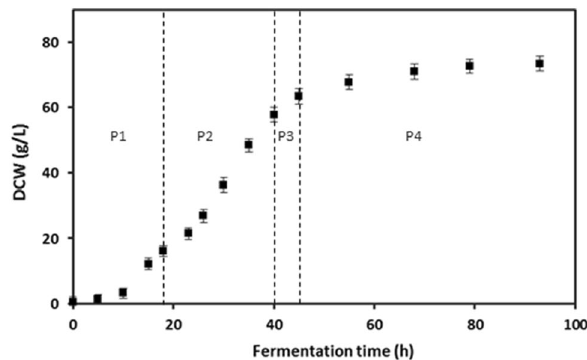
Figure 10. P. pastoris biomass concentration (g DCW/L) evolution during bioreactor fermentation. P1: batch phase in LSBM glycerol 40 g/L, P2: Fed-batch phase with 600 g/L glycerol solution, P3: Adaptation phase with glycerol (600 g/L):methanol (3:1) mixture, P4: Induction phase with methanol as the sole carbon source. Error bars indicate